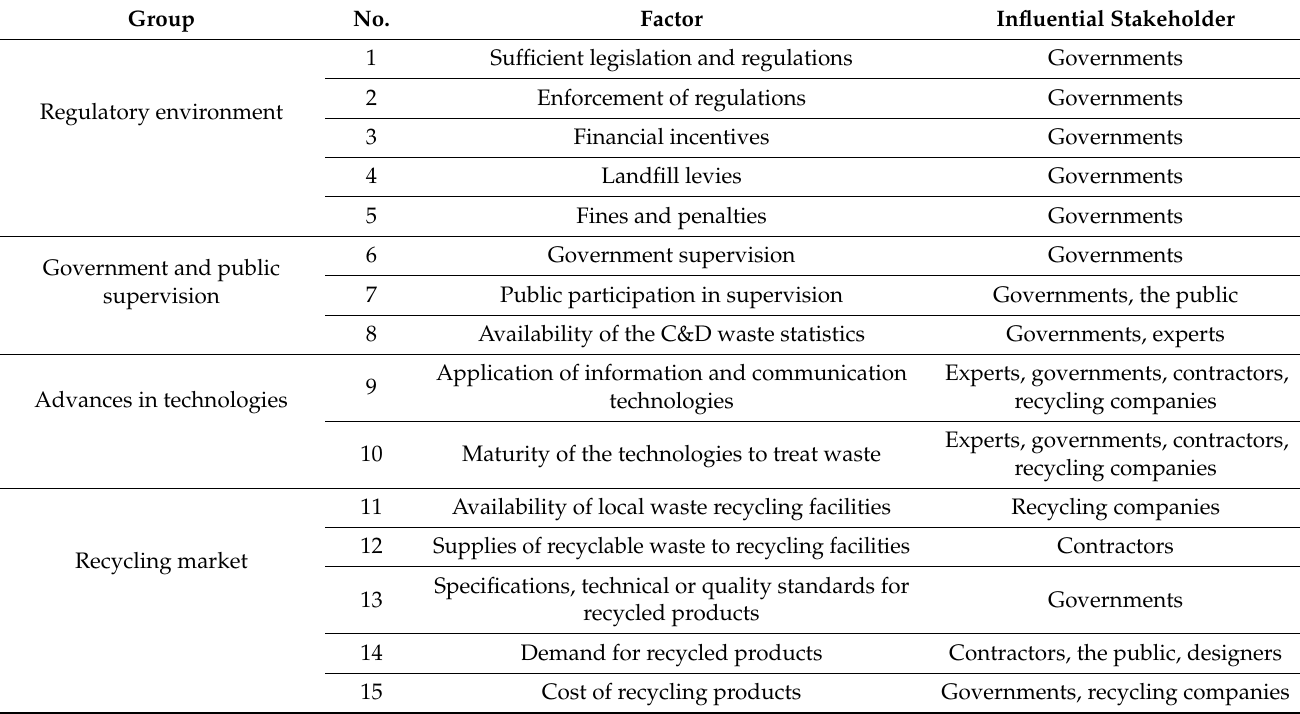
Table 1. Stakeholder-associated factors influencing construction and demolition (C&D) waste management (WM). Group No.